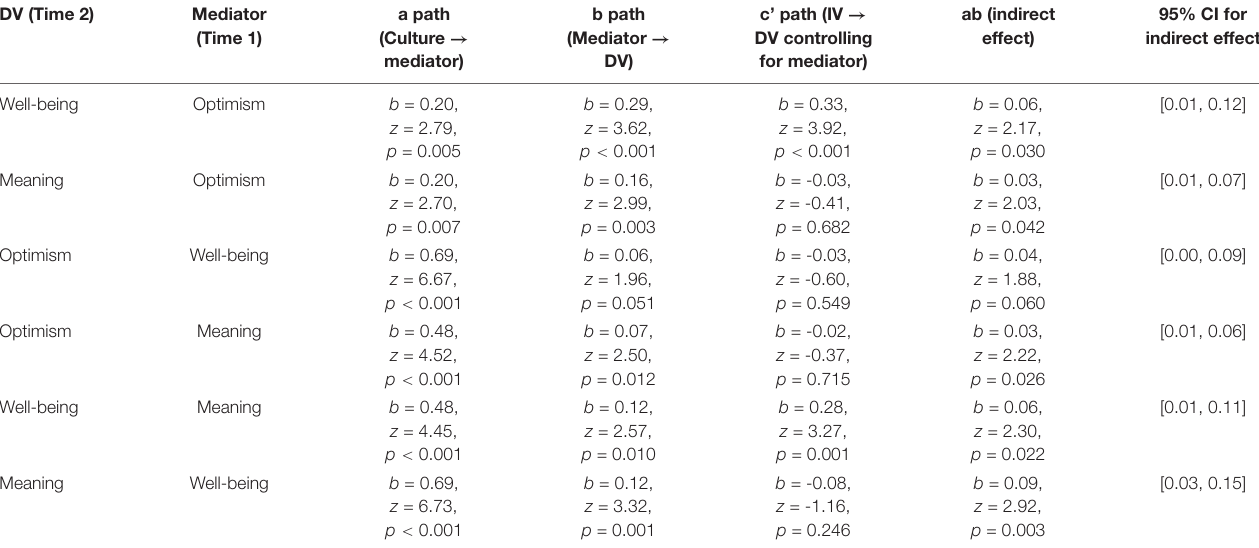
TABLE 2 | Cross-time mediation